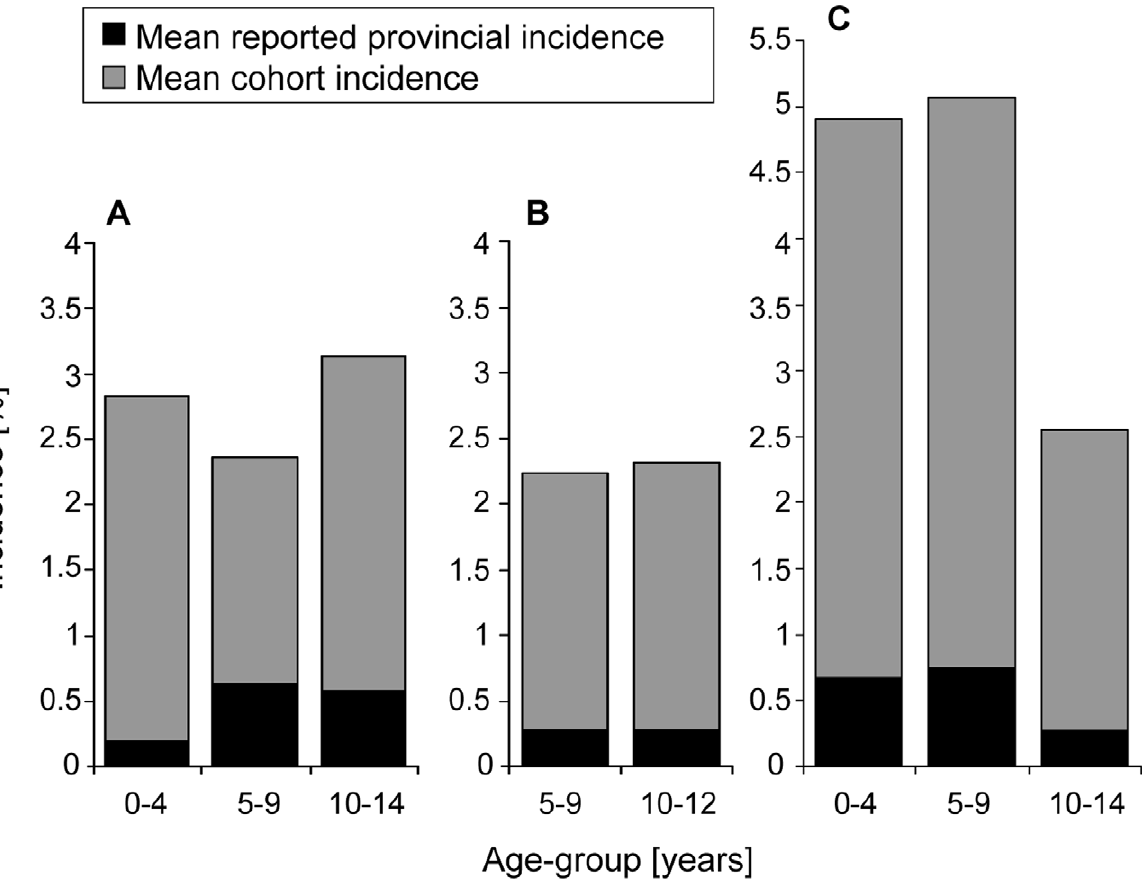
Figure 3. Dengue age-group specific incidence data in Thailand and Cambodia. Differences are shown between mean reported provincial incidence and mean cohort incidence of symptomatic dengue virus infections (inpatients and outpatients) by age-group under surveillance in three field sites: A) Ratchaburi, Thailand, 2006–07; B) Kamphaeng Phet, Thailand, 2004–07; C) Kampong Cham, Cambodia, 2006–07.